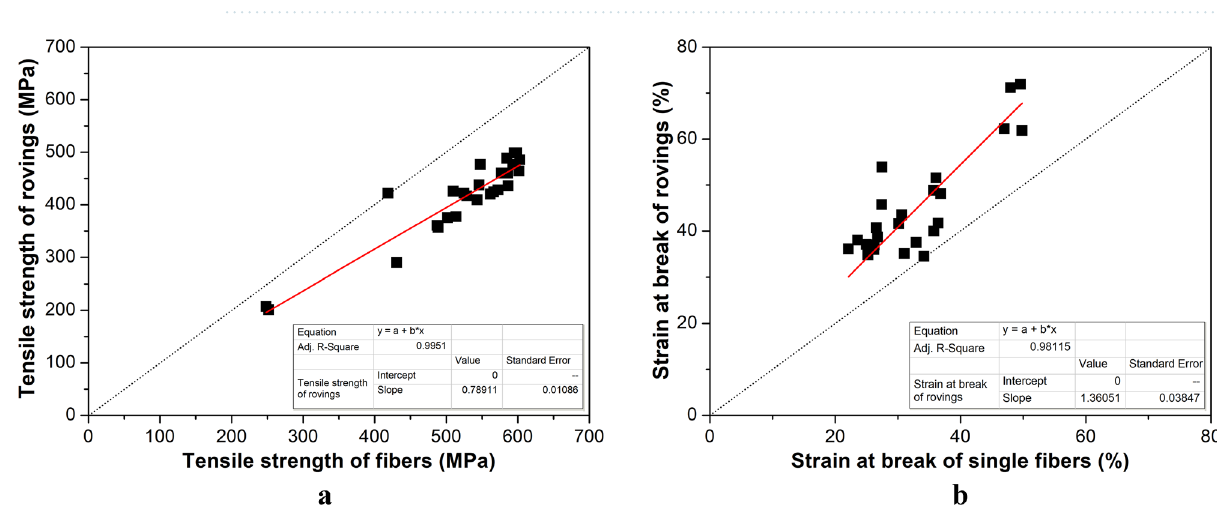
Figure 8. Correlation between the mechanical properties determined on single fibers (x axis) and rovings (y axis): in the case of tensile strength ( a ) and strain at break ( b ).